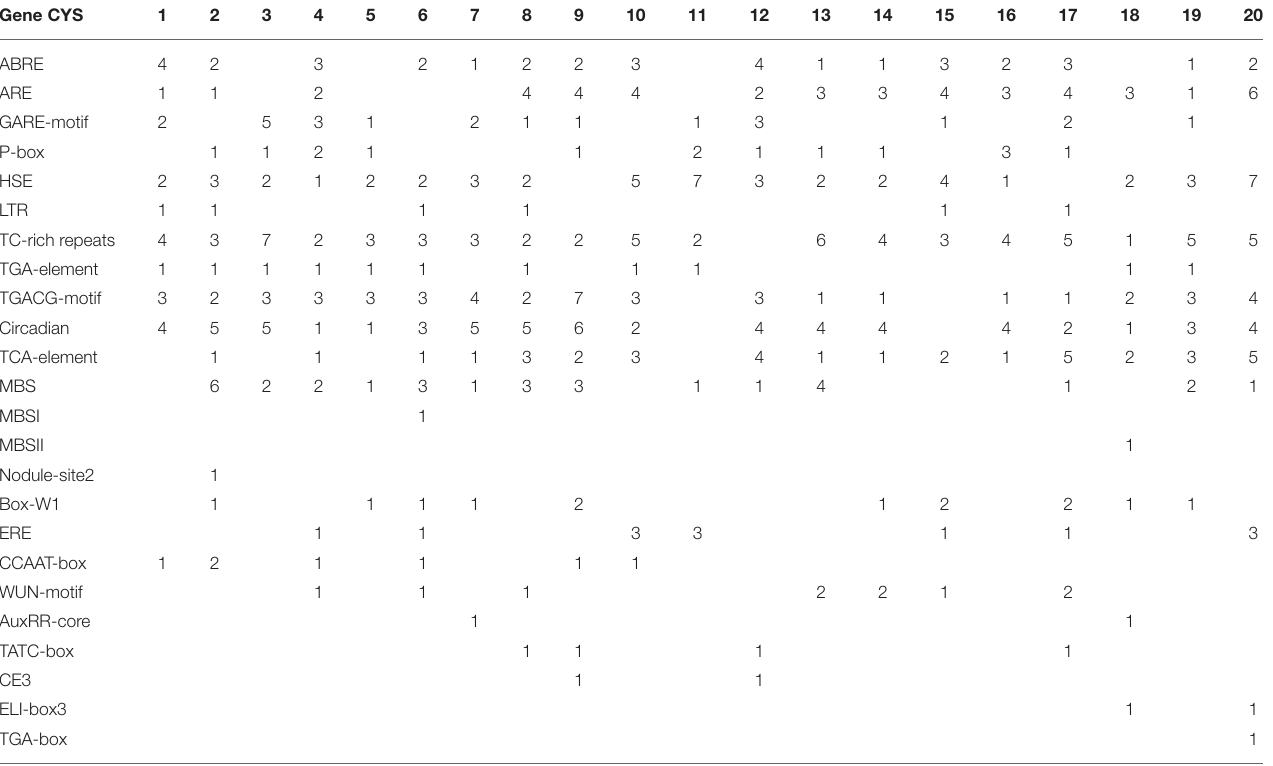
TABLE 2 | Distribution of relative elements in upstream 3000 bp sequences of soybean CYS genes. Gene CYS